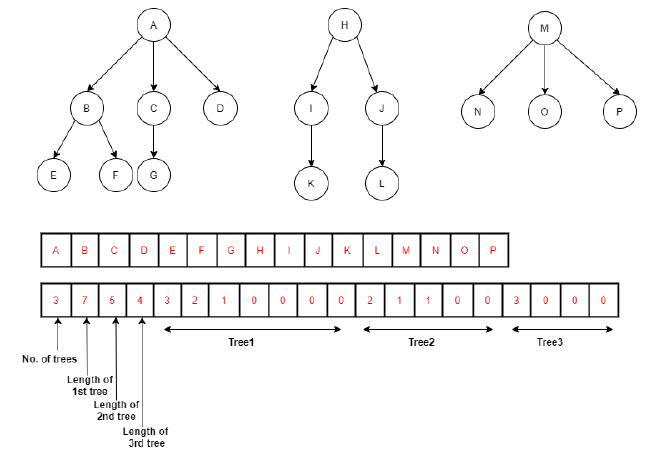
Figure 10. New Forest